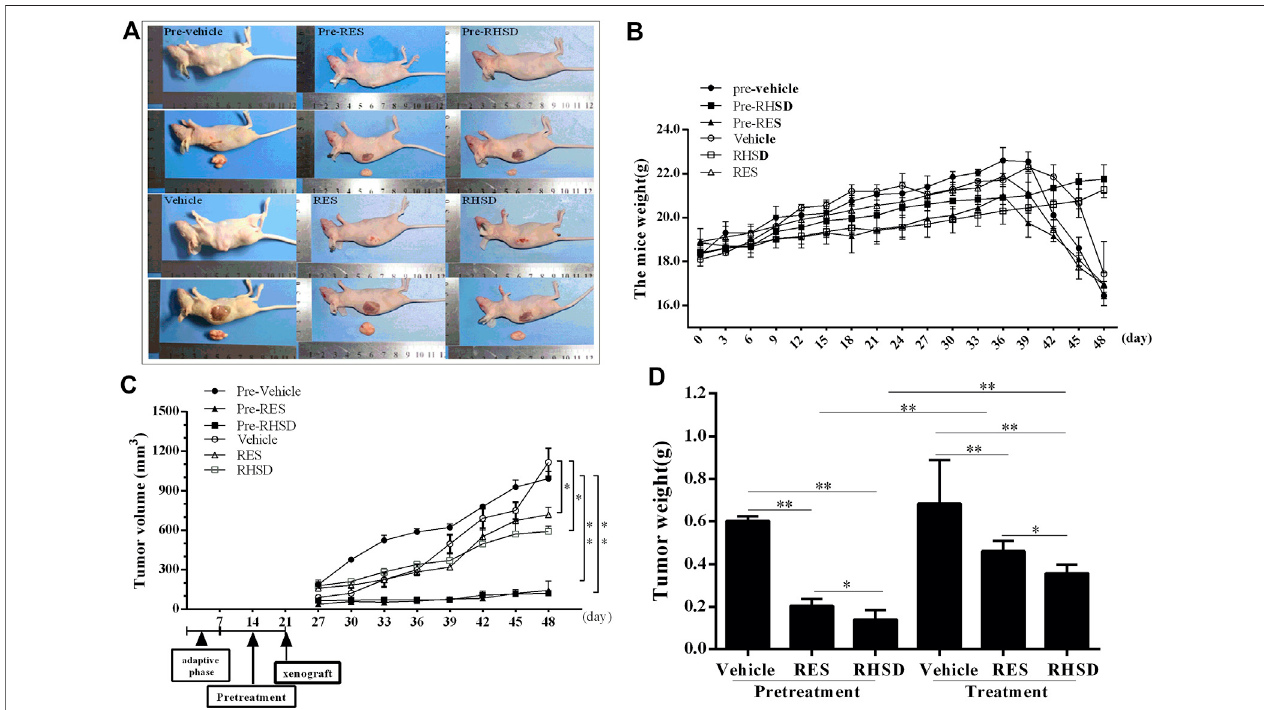
FIGURE5| EffectsofRESandRSHDoncervicalcancertumor growth invivo (A) Typicalimageofsubcutaneoustumorformationinnudemice (B) Miceweight (C) Tumor volume (D) Tumor weight. The data were presented as the mean ± S.D. n (cid:1) 6/group, * p < 0.05, ** p < 0.01.